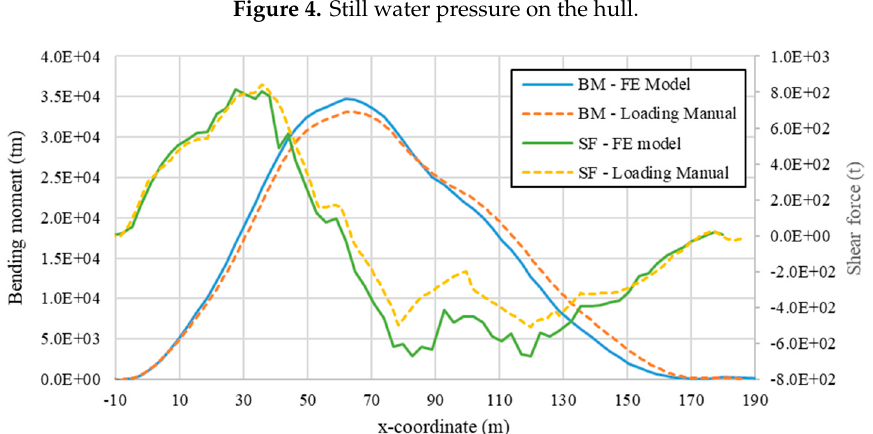
Figure 5. Still water bending moments and shear forces comparison.